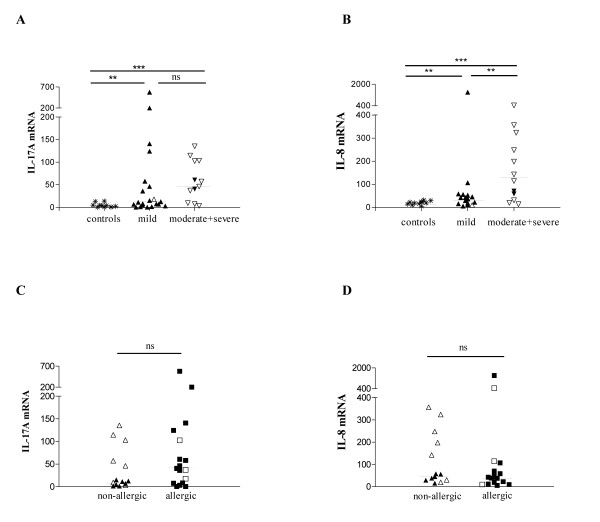
IL-17A and IL-8 mRNA levels in healthy controls and asthmatics. RNA was isolated from induced sputum of healthy controls (n = 11) and asthmatic patients (n = 33) and real time RT-PCR was performed with β-actin, IL-17A and IL-8 specific primers and with VIC-(β-actin) or FAM-(IL-17A, IL-8) labelled specific probes. Results were quantified by the use of a cDNA plasmid-standard and expressed as the ratio of cDNA copy numbers for IL-17A (A-C) or IL-8 (B-D) divided by the cDNA copy numbers for β-actin multiplied by 104 (A-C) or 101 (B-D). Patients were divided in subgroups according to asthma severity following the reviewed GINA criteria [33] (A, B) and allergic state (allergic state was not known in one patient and two patients with only specific IgE for grass pollen were excluded for the comparison of allergic to non-allergic asthma) (C, D). Open symbols represent patients treated with corticosteroids, closed symbols represent patients without corticosteroid-treatment. Comparisons were performed using the Kruskall-Wallis and Mann-Whitney-U test. The median is indicated with a horizontal line. * = p < 0.05, ** = p < 0.01, *** = p < 0.001 and ns = not significant.